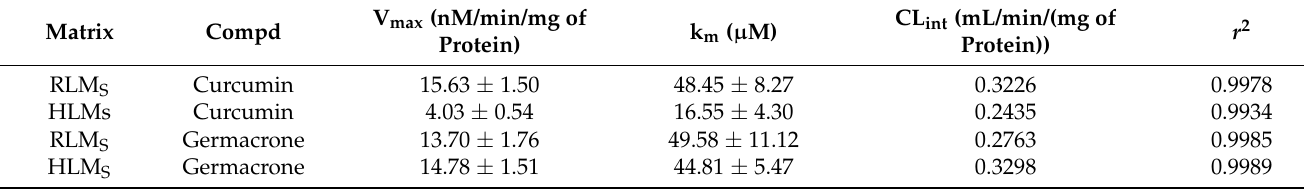
Figure 4. Enzyme kinetics of curcumin ( A ) and germacrone ( B ) in RLMs and HLMs ( n = 3).